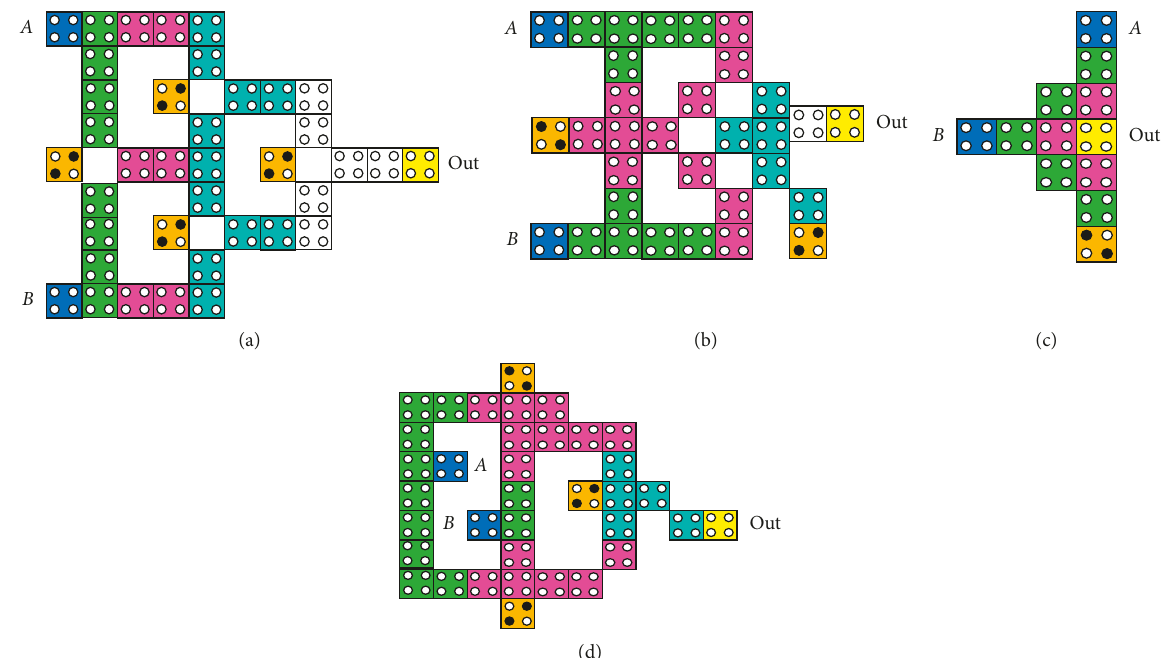
Figure 5: Exclusive-OR gates: (a) design in [24], (b) design in [27], (c) design in [26], and (d) design in [23].